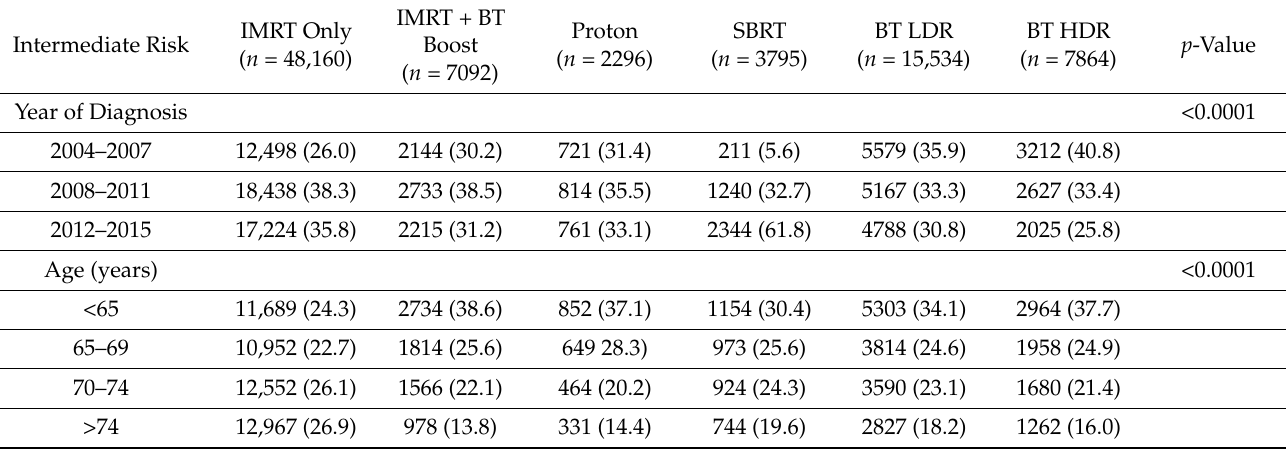
Table 4. Comparative utilization of the six treatment modalities for intermediate-risk prostate cancer